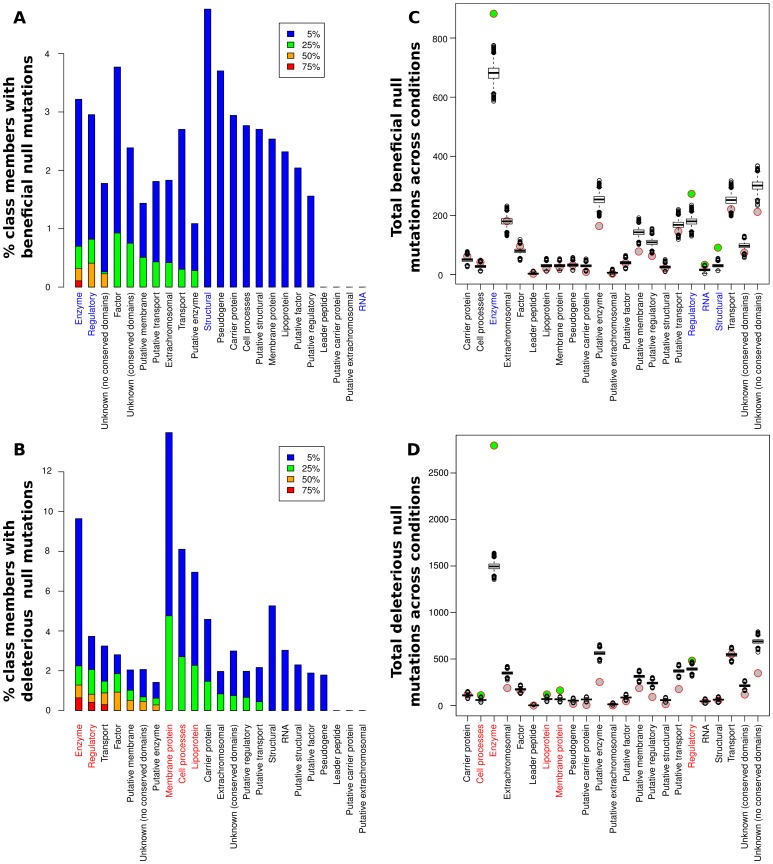
Contributions of null mutations to fitness by functional category.(A,B) Percentage of members of each class for which null mutations caused significantly beneficial (A) or deleterious (B) fitness effects in at least 5%, 25%, 50%, and 75% of the 144 conditions analyzed. Colored labels on the x-axis indicate classes with a significant enrichment in null mutations (q<0.01 by a resampling test; see main text and Table S2). (C,D) Circles: total number of significant beneficial (C) or deleterious (D) null mutations present in each class across all conditions in our meta-analysis. Box plots: simulated null distribution of the same statistic for each class (see main text and Materials and Methods for details). Classes showing significant enrichments (q<0.01) relative to the corresponding null distribution have their label colored on the x-axis and the circle representing their observed value filled in green. No bar appears for the RNA class in panel A because fewer than 5% of the conditions had beneficial nulls from the RNA class; see main text for details. All classifications are from GenProtEC (http://genprotec.mbl.edu/files/geneproductfunctions.txt).